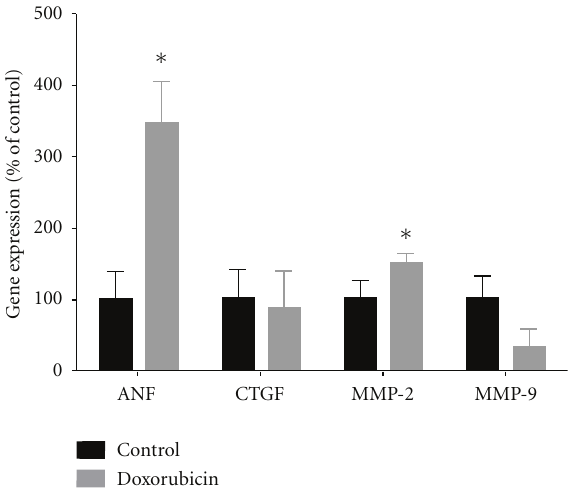
Figure 4: mRNA expression for atrial natriuretic factor (ANF), connective tissue growth factor (CTGF), matrix metalloproteinase- (MMP-) 2, and MMP-9 in control and doxorubicin-treated hearts as quantified by real-time PCR. Individual gene expression was normalized to 18s ribosomal RNA and displayed as a percent of control. ∗ P < 0 . 05 versus control; n =